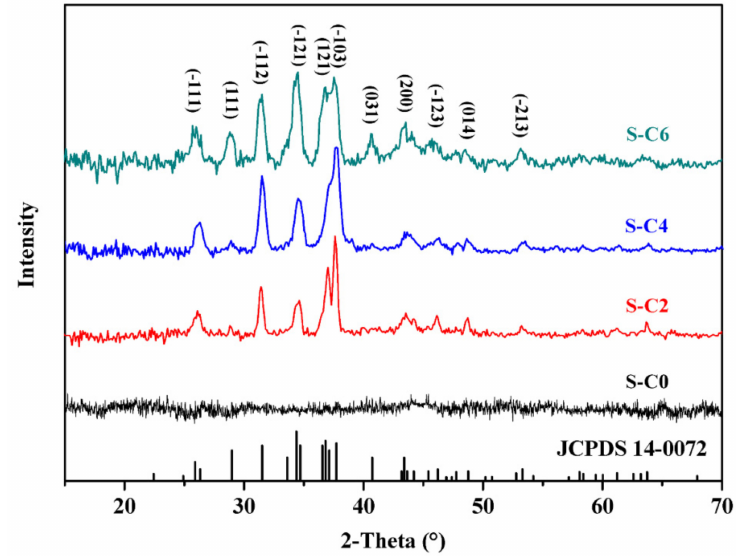
Figure 2. X ray di ff raction (XRD) patterns of the nanocomposite coatings with in situ synthesized Ag 2 S nanoparticles from single-source precursors with di ff erent substituent alkyl chain